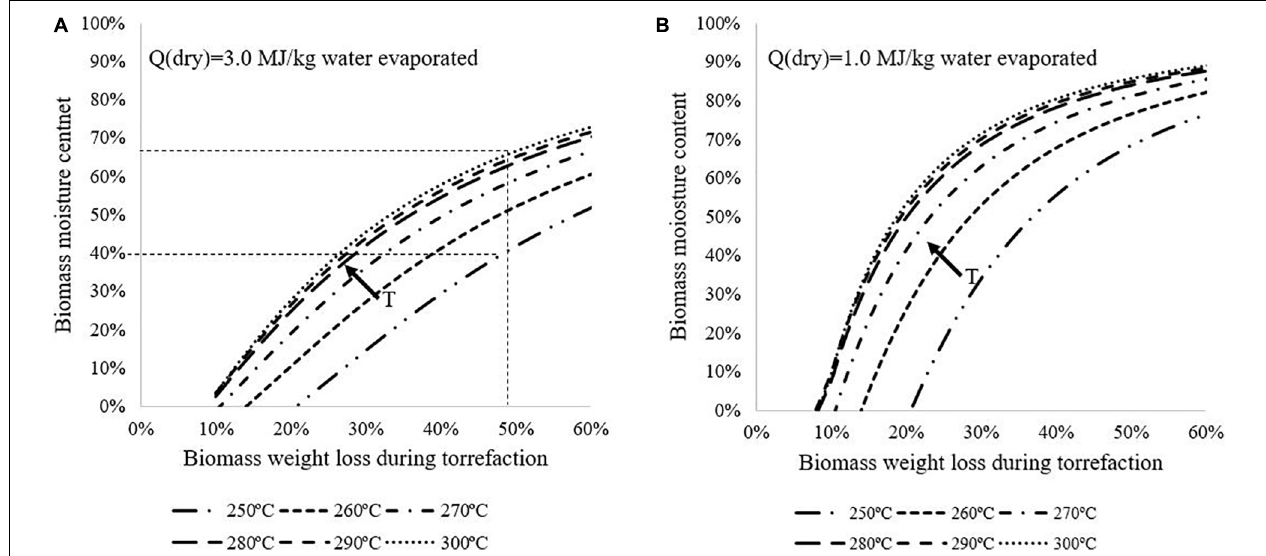
FIGURE 7 | Maximum biomass moisture content (on wet basis) for achieving auto-thermal operation with different drying technologies and torrefaction conditions without N 2 use: (A) : Q(dry) = 3.0 MJ/kg water evaporated; (B) : Q(dry) = 1.0 MJ/kg water